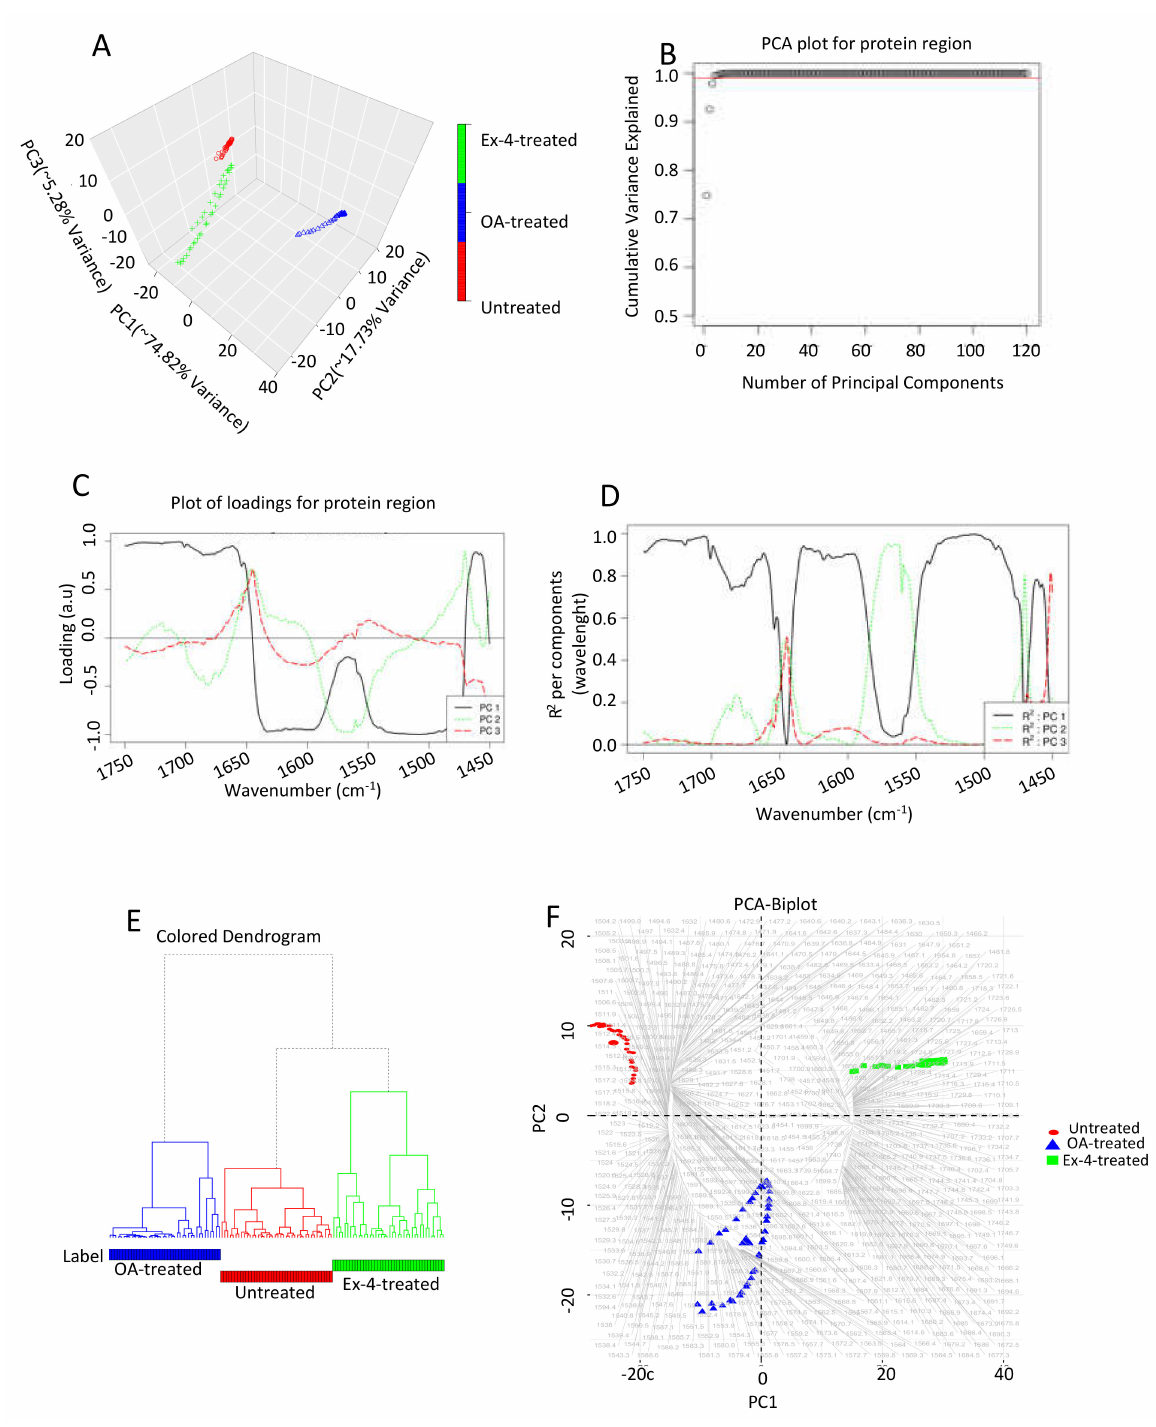
Figure 7. Chemometric analysis of the FTIR experimental data on the protein region (1750–1450 cm − 1 ). ( A ) PCA score plot. ( B ) Amount of variance captured by PCs. ( C ) Loading plots for the spectral data. ( D ) Squared correlation for the first three PCs for the spectral collection. ( E ) Hierarchical clustering of the spectra for the different experimental samples. ( F ) PCA biplot explaining which wavenumbers are associated with which treatment samples. Each treatment condition was repeated three times. The FTIR spectra analyzed were 70, 80, and 80 for the untreated, steatotic, and Ex-4-treated HepG2 cells,